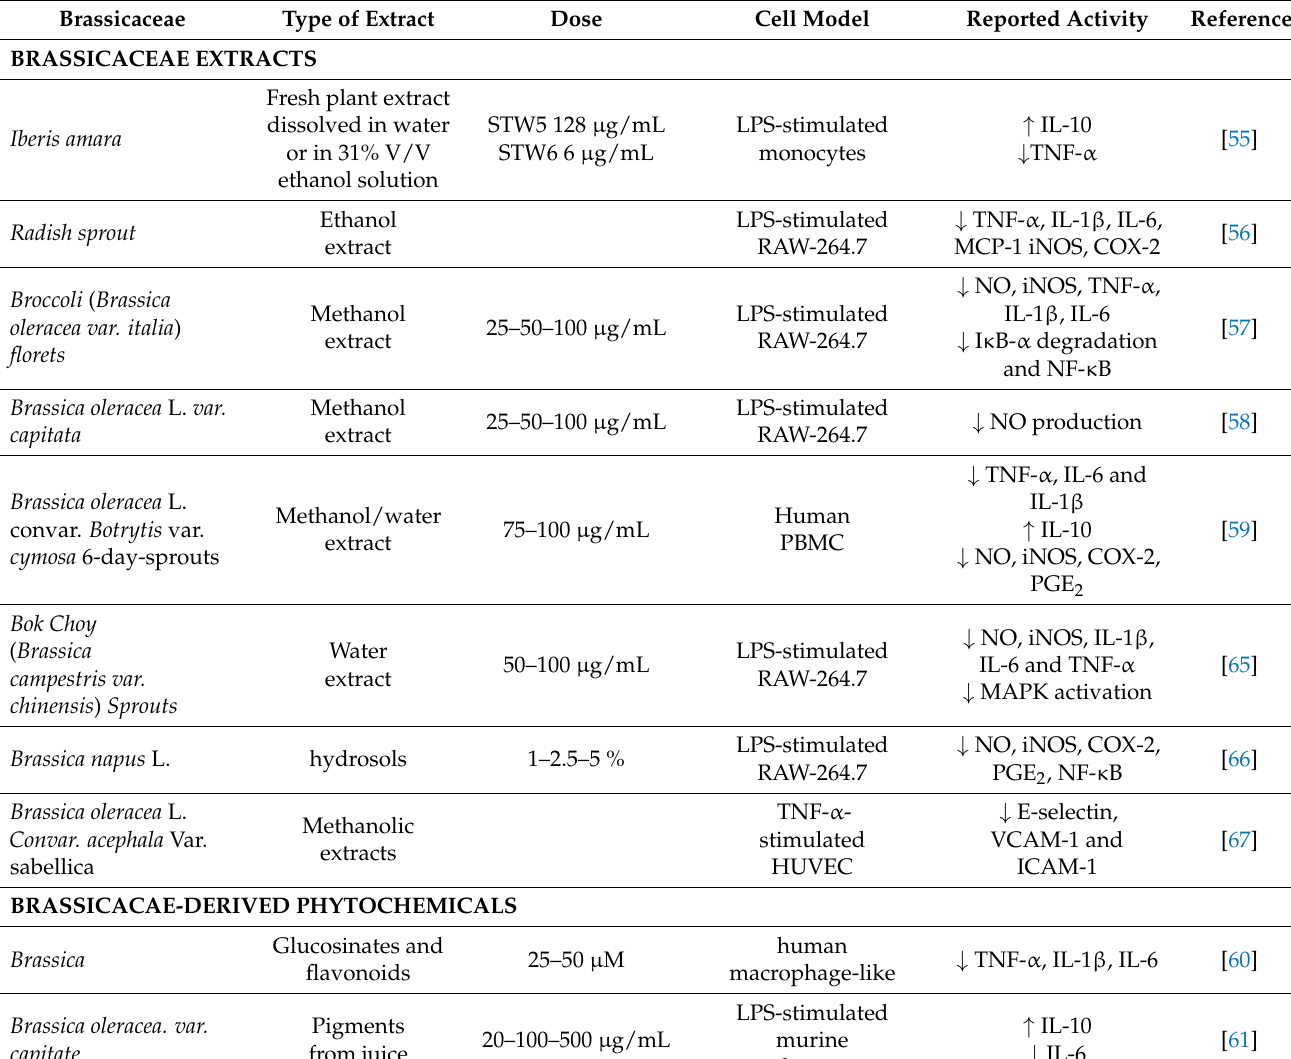
Table 1. In vitro effects of Brassicaceae on different cellular